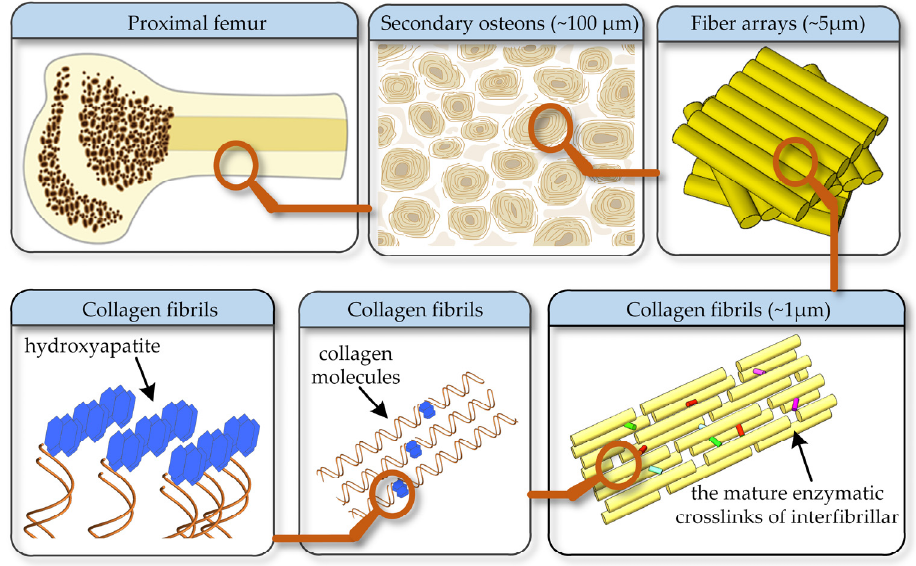
Figure 1. The multistage structure of bone.